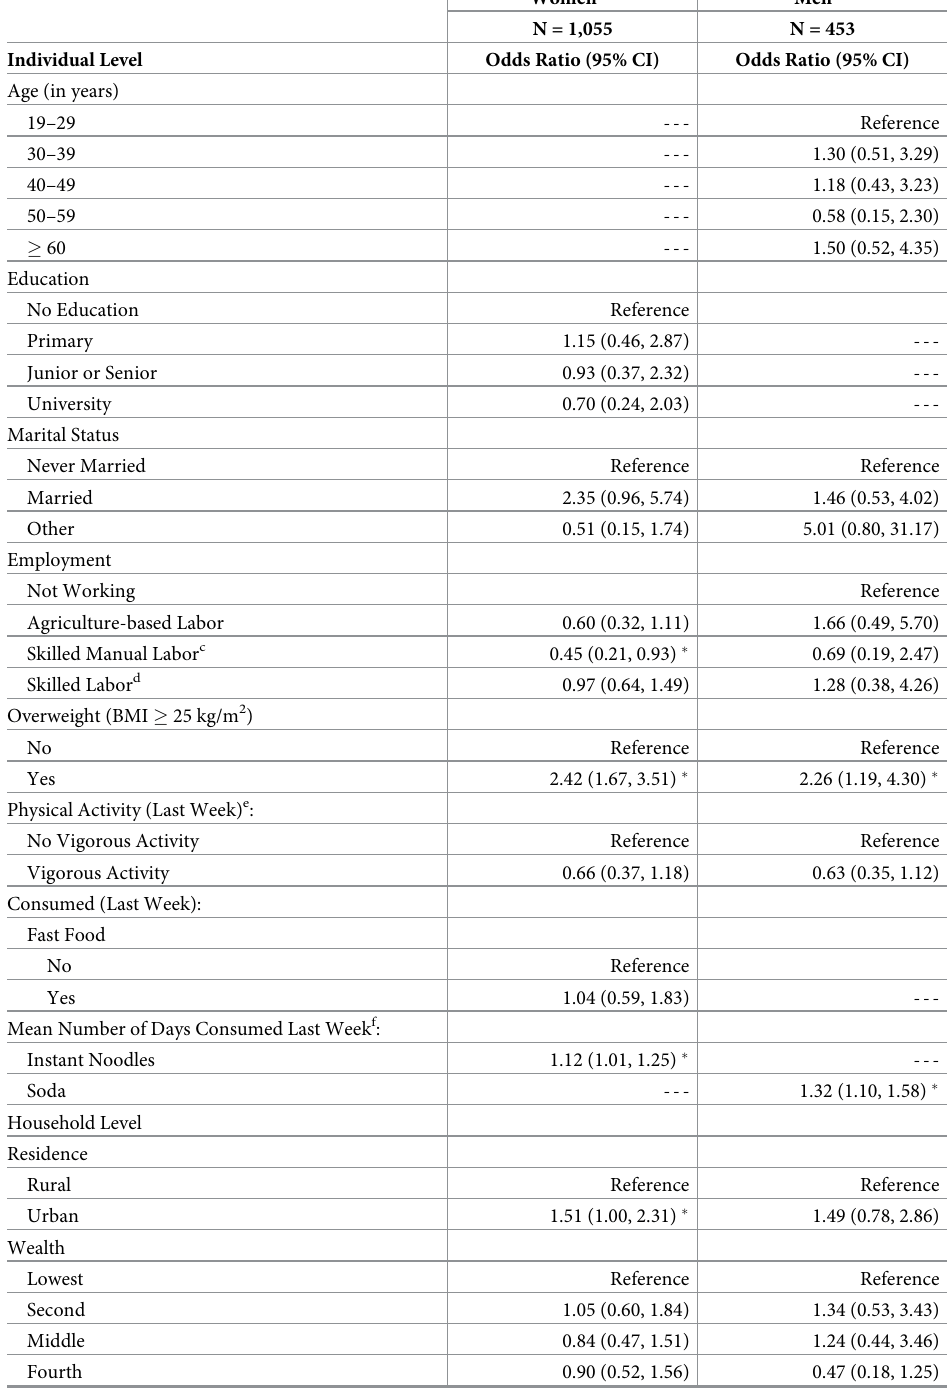
Table 3. Multivariable Logistic Regression Testing the association between selected characteristics and elevated hs-CRP among adults in Indonesia,